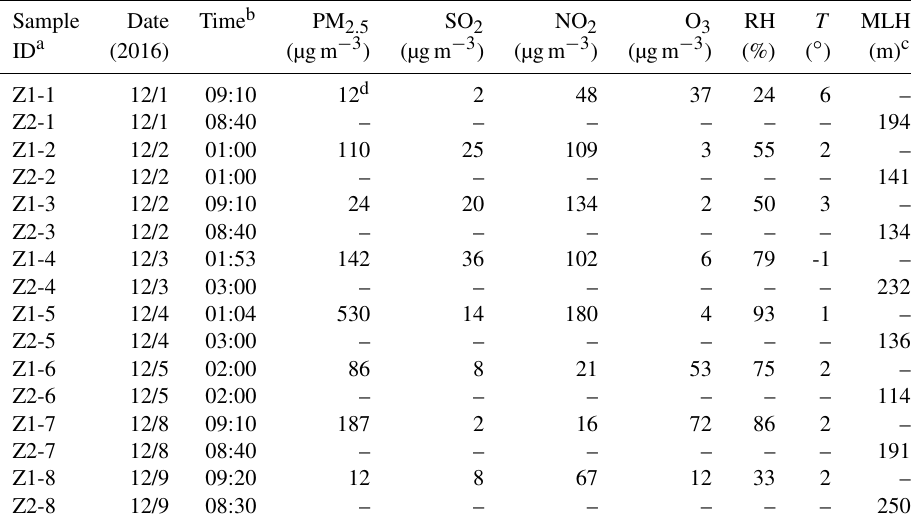
Table 1. Sample information and meteorological conditions.